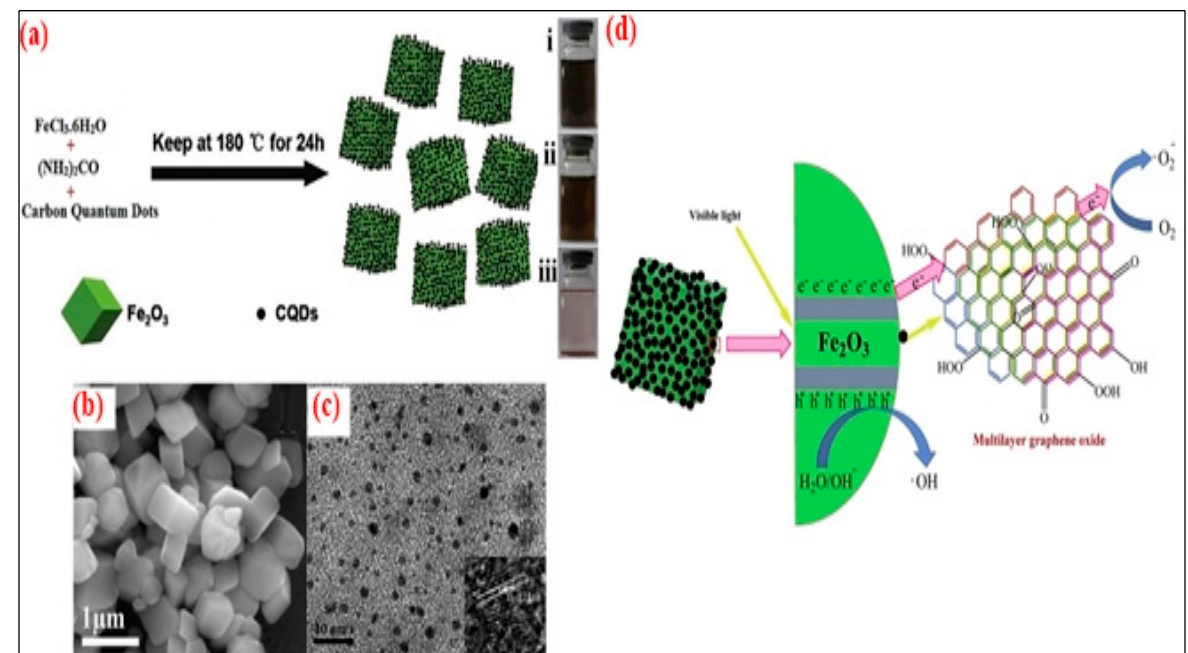
Figure 9. ( a ) Hydrothermal synthesis of Fe 2 O 3 /CQDs NCs, which photographs demonstrate; (i) aqueous dispersion of CQDs, (ii) solution containing CQDs, with precursors and (iii) final nano-composite, ( b ) SEM image of Fe 2 O 3 /CQDs, ( c ) HRTEM images of Fe 2 O 3 /CQDs NC, ( d ) schematic representation of interactions between CQDs and Fe 2 O 3 NC indicating the exceptional photocatalytic performance under visible light. (Reprinted with permission from [155] Royal Society of Chemistry, License No. 600097123).